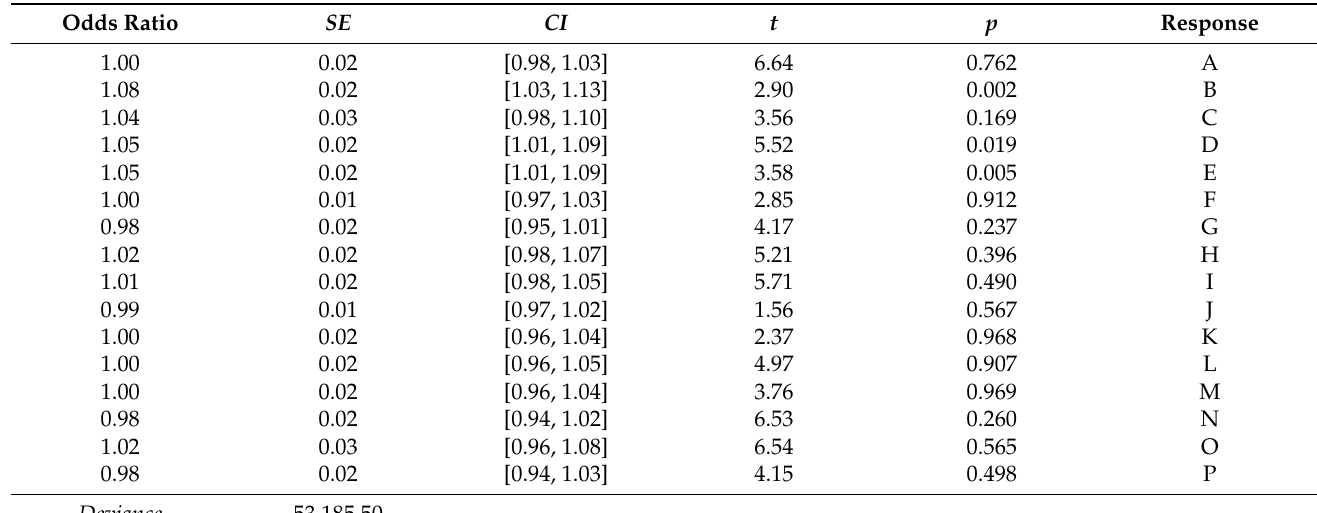
Table A15. Emospace widget response multinomial logistic regression model for neuroticism concerning the space of a widget as